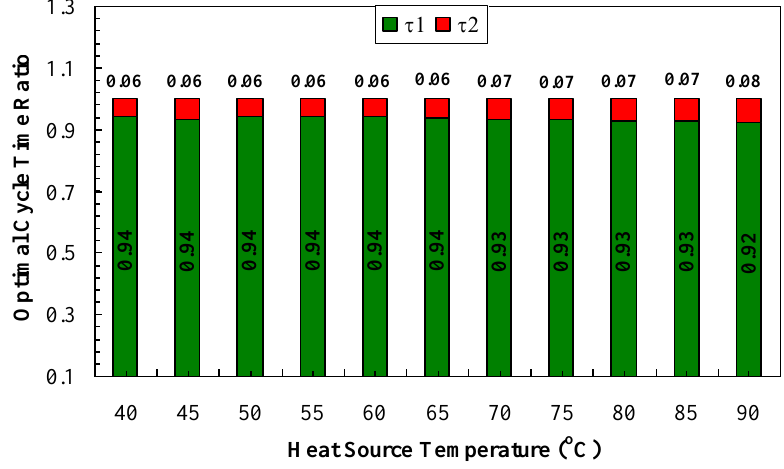
Figure 4. Optimal cycle time ratio of the proposed cycle for different heat source